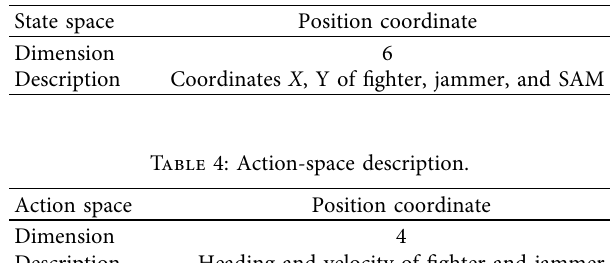
Table 3: State-space description.